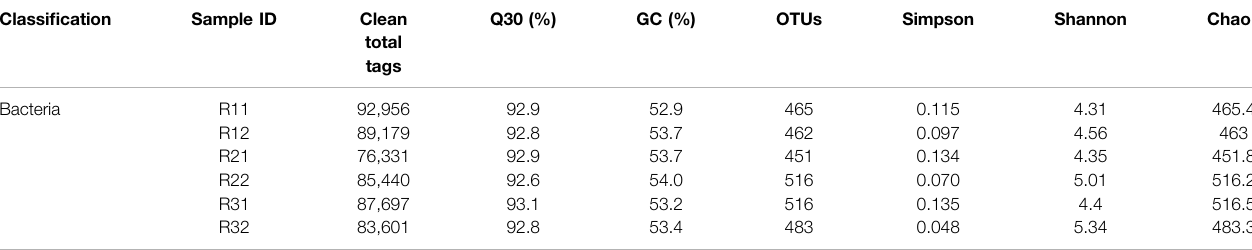
TABLE 4 | Statistics of sample bacteria sequencing data processing results and alpha diversity. Classi fi cation